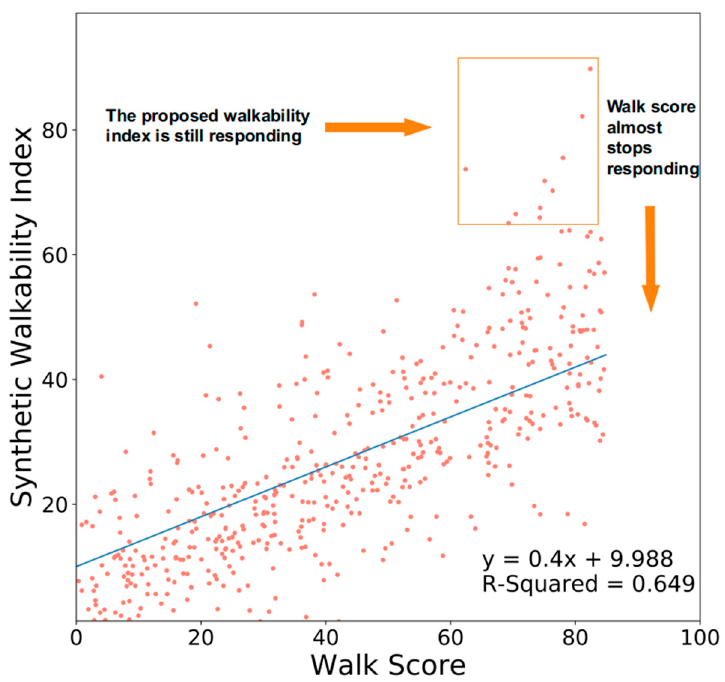
Figure 7. Scatterplot of synthetic walkability index against Walk Score using 500 random samples at individual location in the study